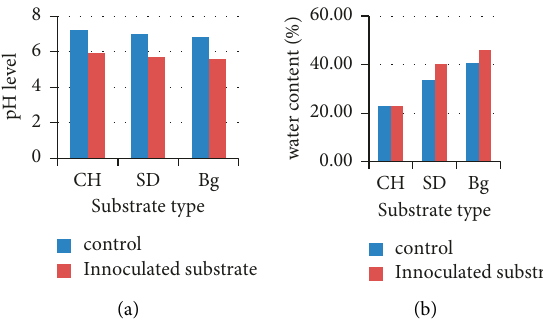
Figure 6: Effect of mycelium development on pH and water content.